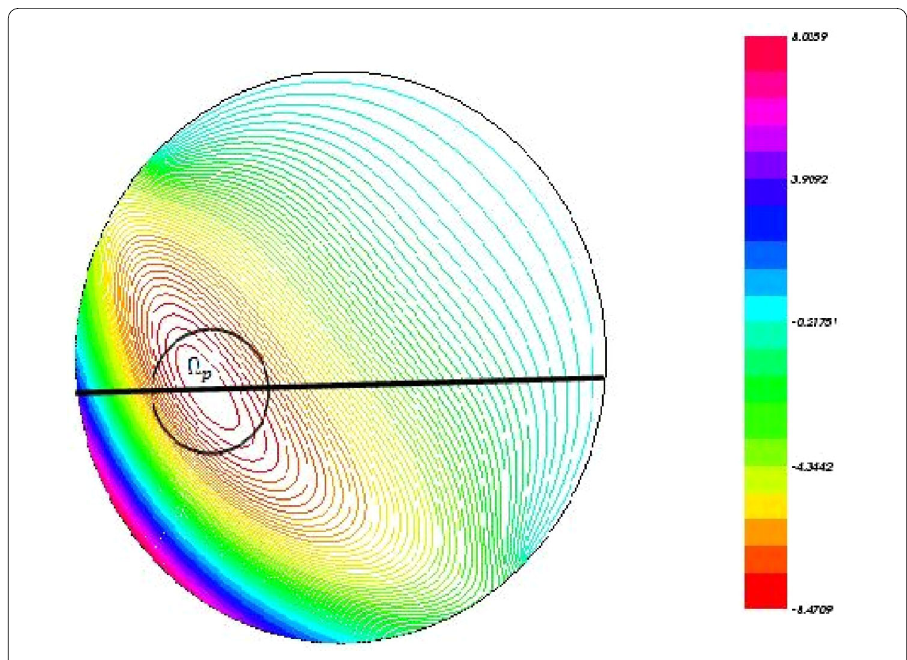
Figure 3 Isovalues of the topological gradient δ T